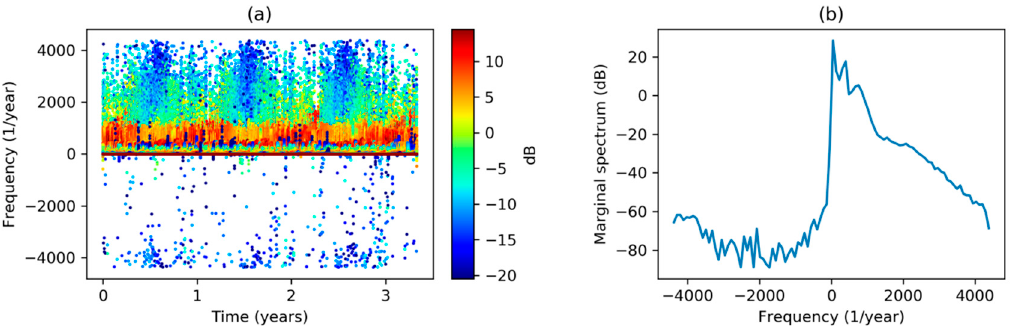
Figure 10. Electricity demand Hilbert–Huang Transform: ( a ) Hilbert–Huang Spectrum (scatter plot); ( b ) Marginal Hilbert–Huang Spectrum.